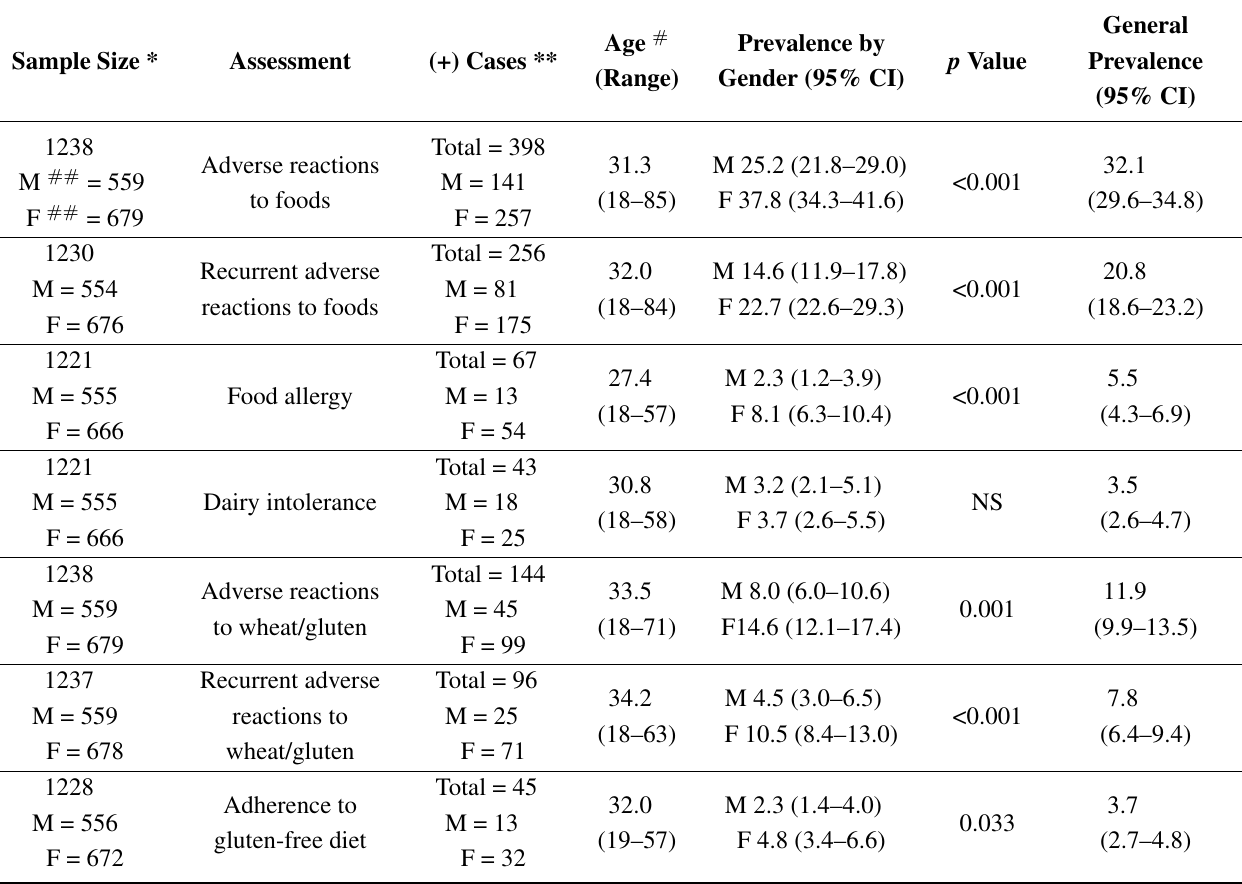
Table 3. Study population and prevalence